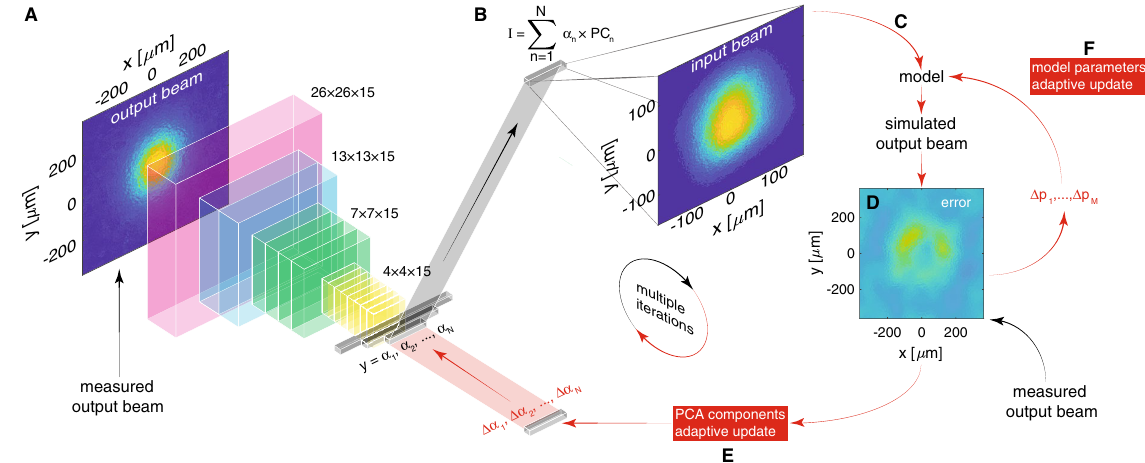
Figure 5. ( A ) The measured beam output is fed into the CNN of convolutional layers with LeakyReLU activation functions followed by dense layers with ReLU activations. The CNN outputs principal component coefficients (α 1 , . . . , α N ) which generate an input beam distribution ( B ) used as an input to the simulation ( C ). ( D ) Simulation output is compared to the measured beam output to adaptively fine tune both the principal components ( E ) and model parameters ( F